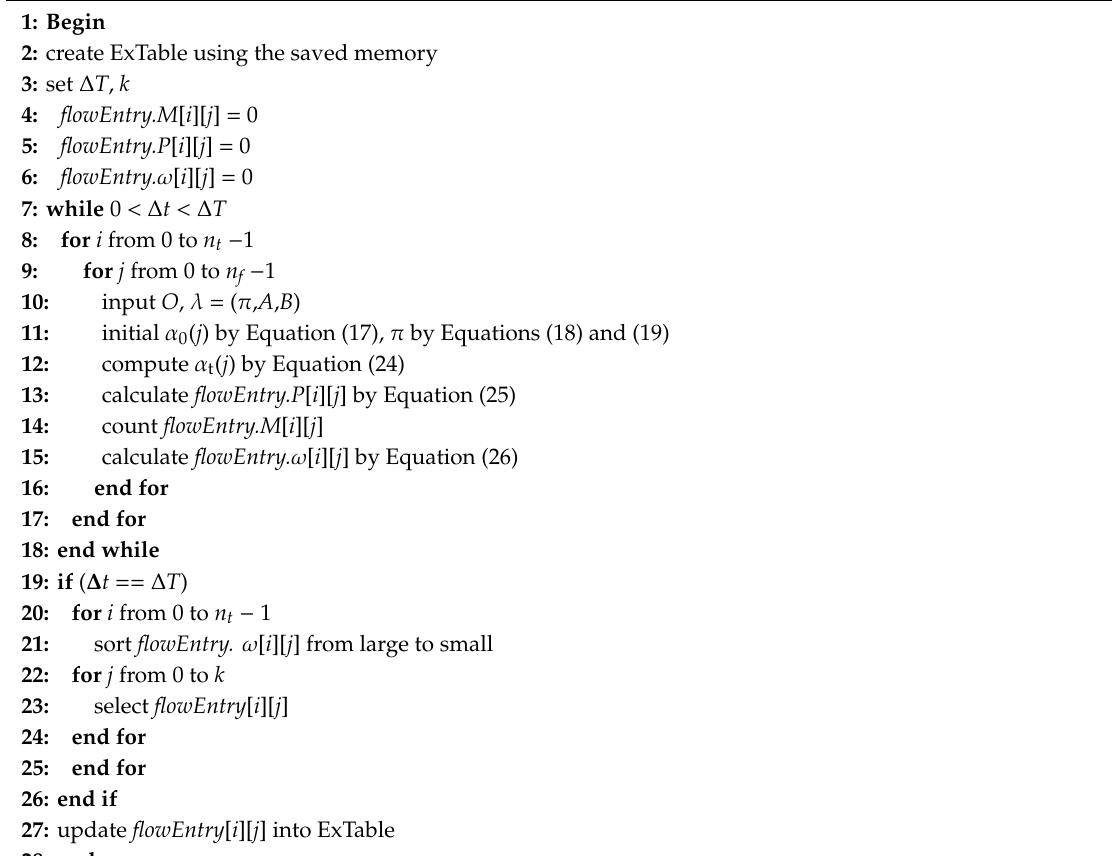
Algorithm 2. Selection operation of popular